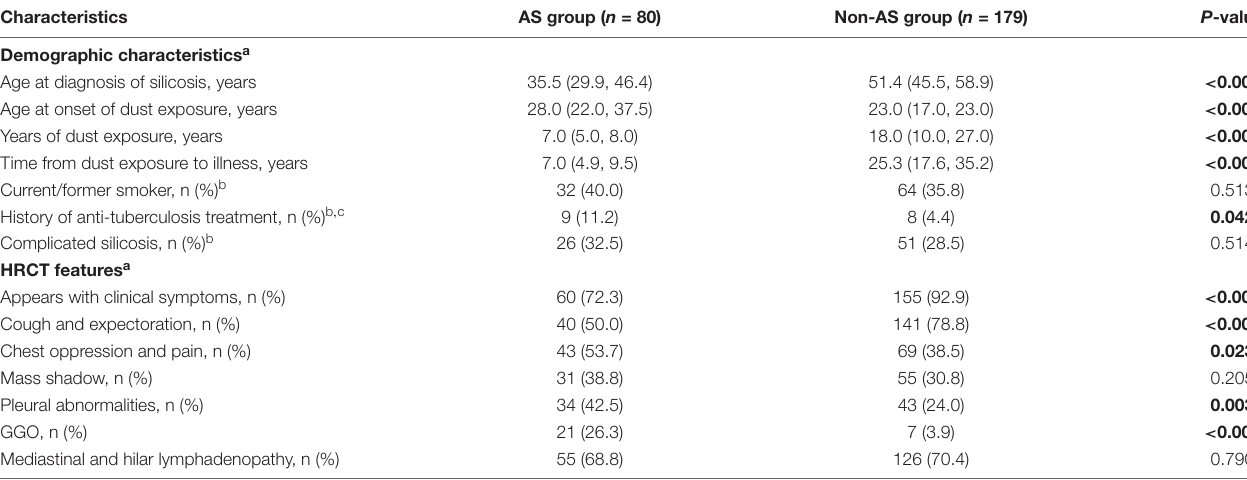
TABLE 1 | Demographic characteristics and HRCT features of AS group versus non-AS group. Characteristics